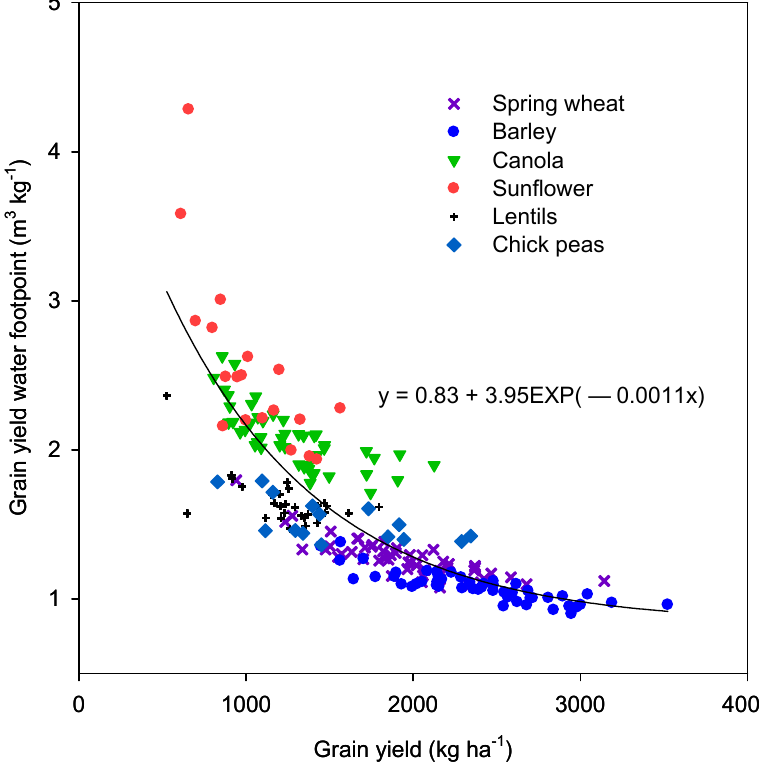
Figure 9. Relationship between crop grain yield-based water footprints (WFs) and grain yields in Saskatchewan.